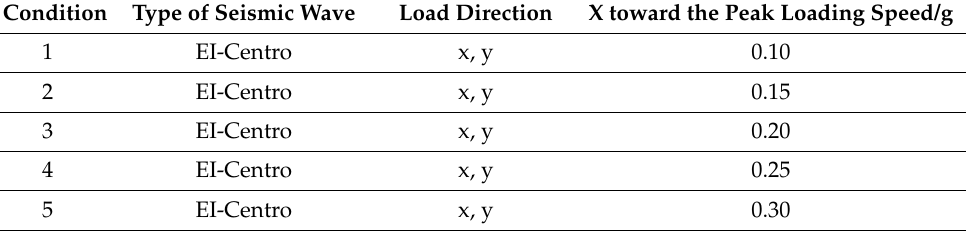
Table 1. Loading condition of the seismic waves.